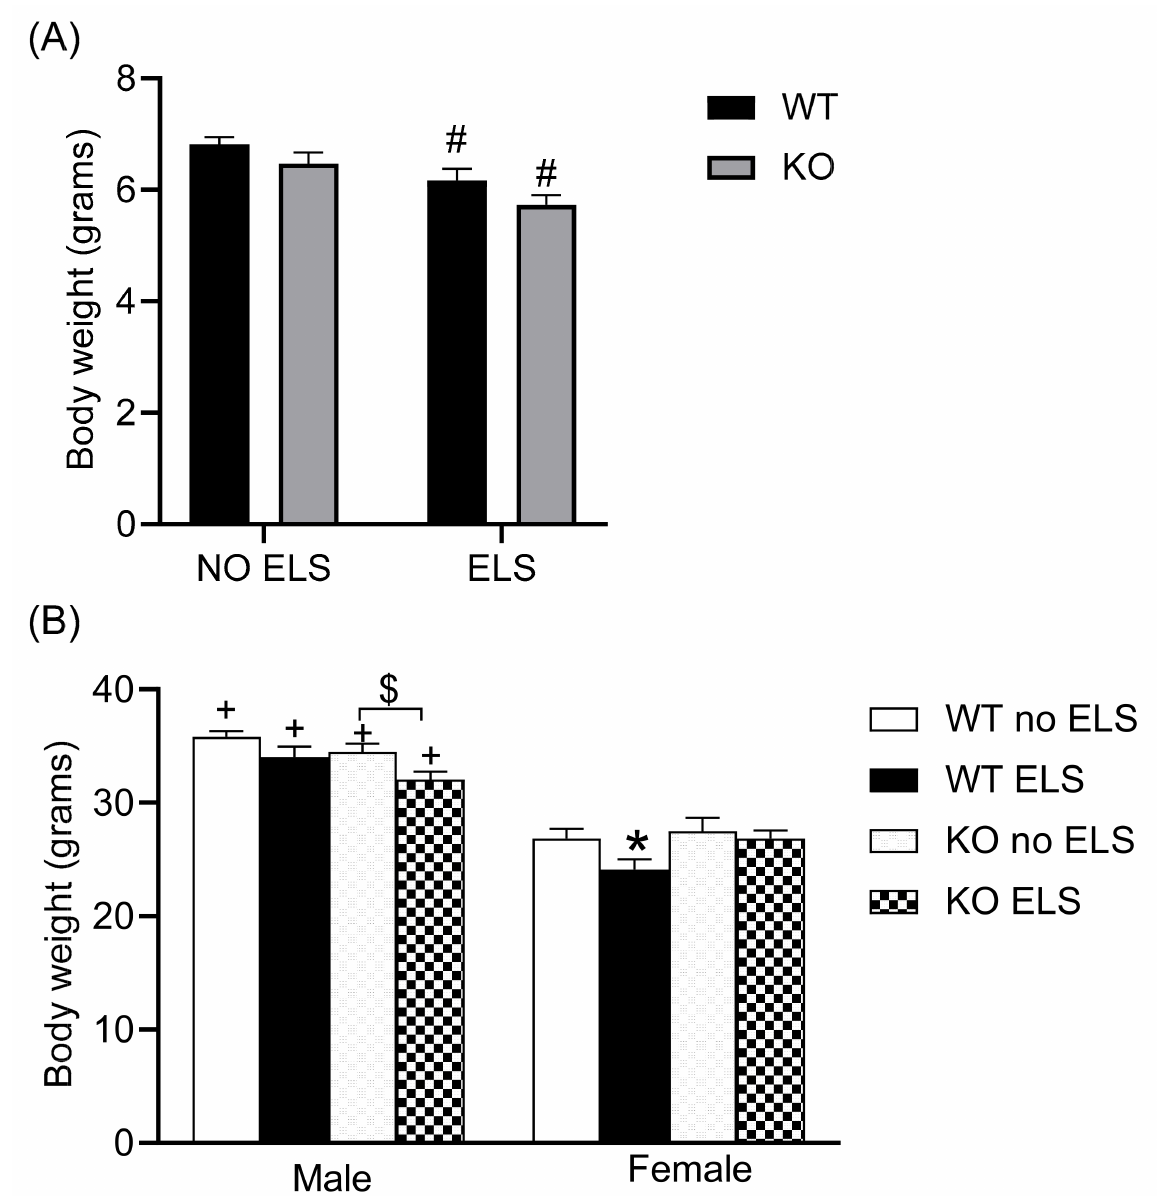
Figure 6. Effect of early life stress in WT and GPR37KO mice on body weight (BW). BW at P12 ( A ), N/group: WT no-ELS = 22, WT ELS = 16, KO no-ELS = 14, KO ELS = 11. BW of adult mice ( B ), N/group: WT no-ELS male = 10, WT ELS male = 10, KO no-ELS male = 10, KO ELS male = 7, WT no- ELS female = 11, WT ELS female = 7, KO no-ELS female = 12 and KO ELS female = 8. All data represent mean ± SEM. * p < 0.05 treatment difference within genotype, # p <0.05 versus corresponding WT; + p < 0.05, with respect to sex, $ p > 0.05 < 0.1 calculated by two-way ANOVA/three-way